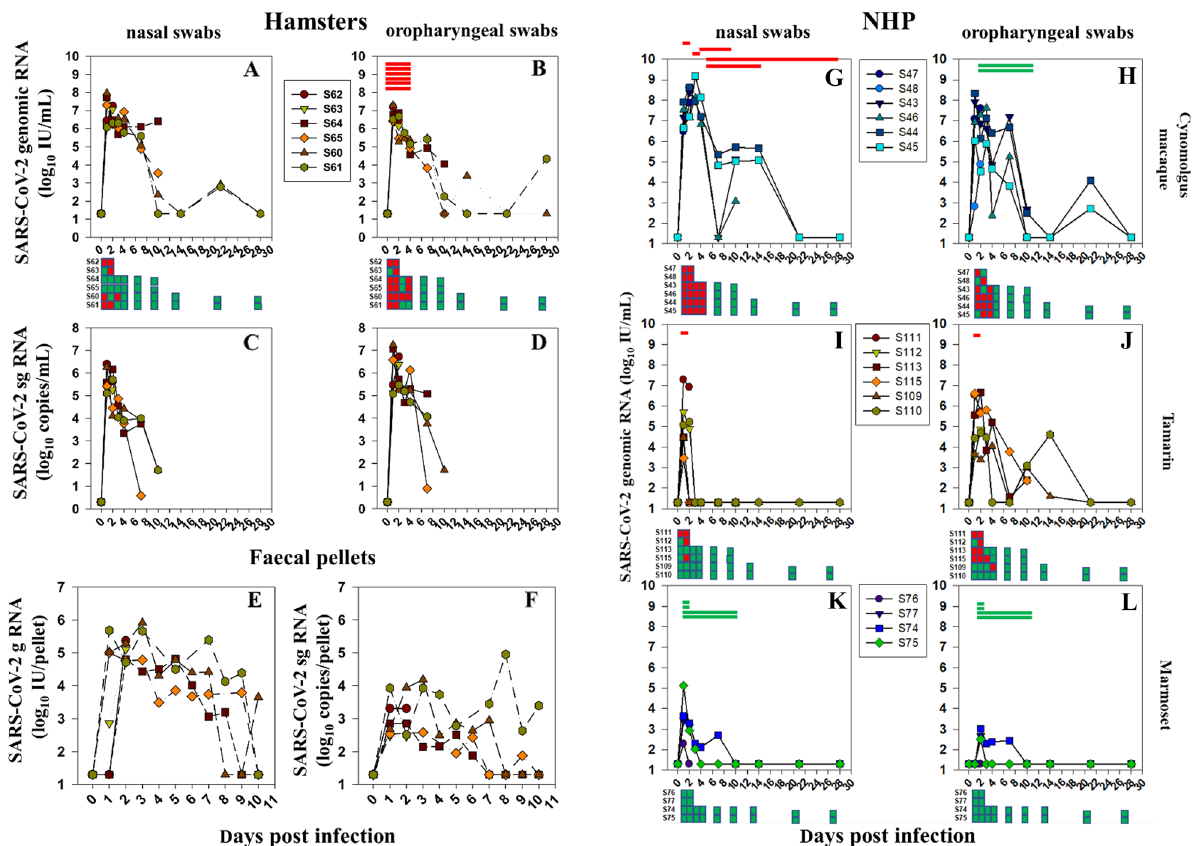
Figure 2. Infectivity and shedding profiles of SARS-CoV-2/Vic-01 in four independent species. ( A , B ) Comparative shedding outcomes in nasal and oral/mouth swabs in female hamsters followed over the time course. SARS-CoV-2 genomic RNA levels expressed as Log 10 International Units (IU)/mL calibrated against the WHO International Standard for SARS-CoV-2 RNA (NIBSC# 20/146/Eng02) amplified with E gene primers in nasal and oral swabs monitored over the 28 day time-course. Qualitative microculture data using VeroE6/ TMPRSS2 indicator cells shown in squares as green (no virus) and red (positive virus culture) at the times indicated. Red bars indicate positive antigen lateral flow device result where sampled. ( C , D ) Subgenomic (sg) RNA levels expressed as copies/mL in female hamsters over the acute period. ( E , F ) Genomic (g) and subgenomic RNA levels in faecal pellets recovered daily over the first 10 days in female hamsters. Comparable nasal and oral swab data are shown for the 3 NHP species: cynomolgus macaques ( G , H ), tamarins ( I , J ) and marmosets ( K , L ). Culture data are similarly indicated by red or green squares and lateral flow device result by red or green bars where in rectal swabs in cynomolgus macaques (S45, S46, S48) but infectious virus was not recovered onto VeroE6/ TMPRSS2 cells (Fig. S7). Comparison of New World NHP species revealed differential susceptibility between marmosets and tamarins, but both lower than cynomolgus macaques. Notably, tamarins exhibited multiple markers of productive upper airway infection (Fig. 2I,J), peaking log 10 5–7 IU/mL gRNA in oral and nasal swabs with some persisting signals 14 dpi in oral swabs. Infectious virus was recovered from all tamarins from at least one time-point (1–3 dpi), more frequently from oral (9/20) than nasal swabs (4/20) that could not be attributed to in-put virus; NP anti- gen was also detected in tamarin S111 2 dpi at peak gRNA; sgRNA signals were detected in tamarins but at low levels. Marmosets had significantly lower peak gRNA 2 dpi, undetectable 7 dpi (Fig. 2K,L); neither antigen nor infectious virus were detected at any point in marmosets. Despite overall lower infectivity levels in marmosets, both S75 and S74 signalled for gRNA significantly above threshold, S75 peaking ~ log 10 5 IU/mL 2 dpi. Overall, applying multiple markers of decreasing virus infectivity, this Vic-01 passage 4 stock across the four species could be represented as: Cynomolgus macaques > hamsters > tamarins > marmosets Tissue biodistribution and timing of SARS‑CoV‑2 Vic‑01 genome detection. Comparison of viral genome biodistribution across multiple anatomical sites for each species using an assay expressing genomic RNA levels as International Units (IU)/µg total RNA (Fig. 3), indicated differences in timing and distribution